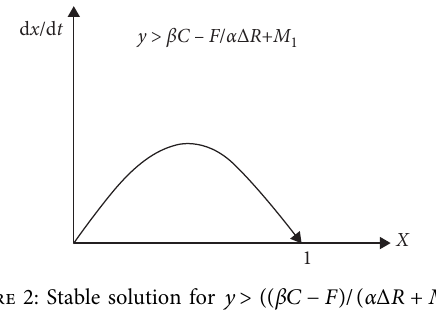
Figure 5: Stable solution for x > ((( 1 − β ) C − F ) / (( 1 − α ) Δ R + )) . M )) . 2 1